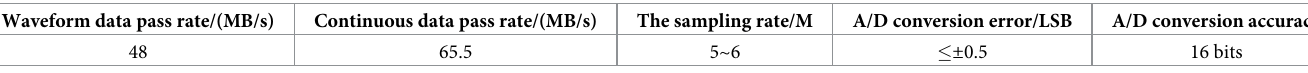
Table 3. Technical indexes of DS5-8A full information AE signal